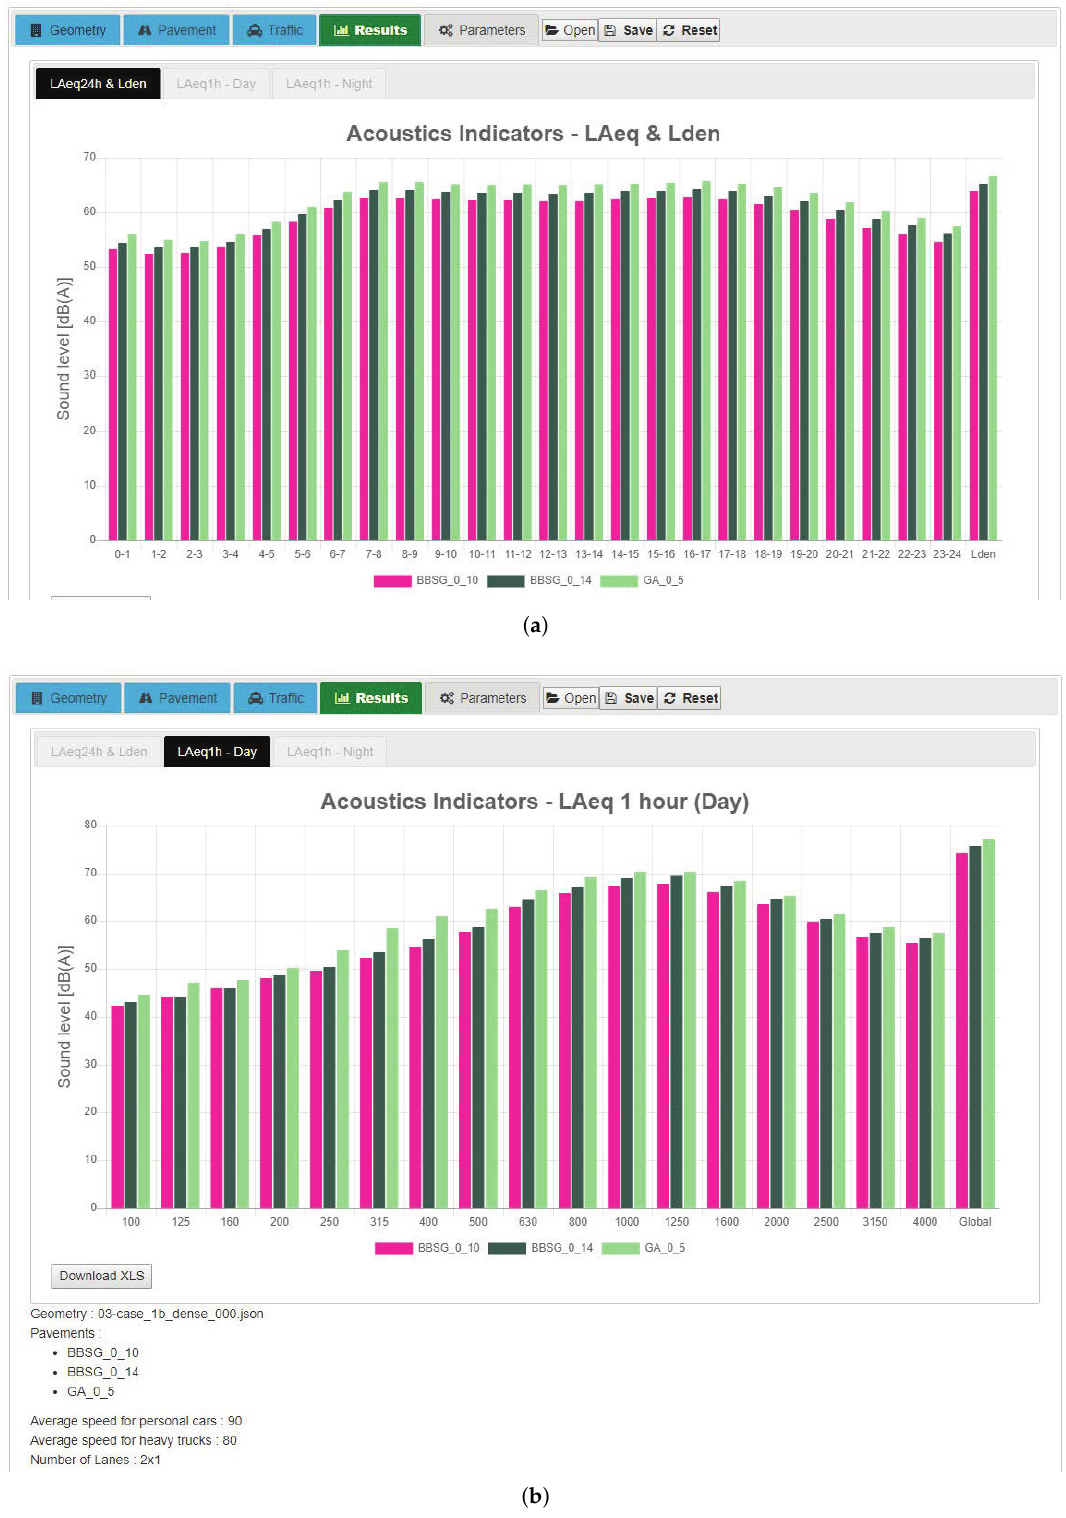
Figure 5. DEUFRABASE screenshots. Illustration of the results produced by the web tool (release V3). ( a ) L Aeq,24h and L den results. ( b ) L Aeq,1h